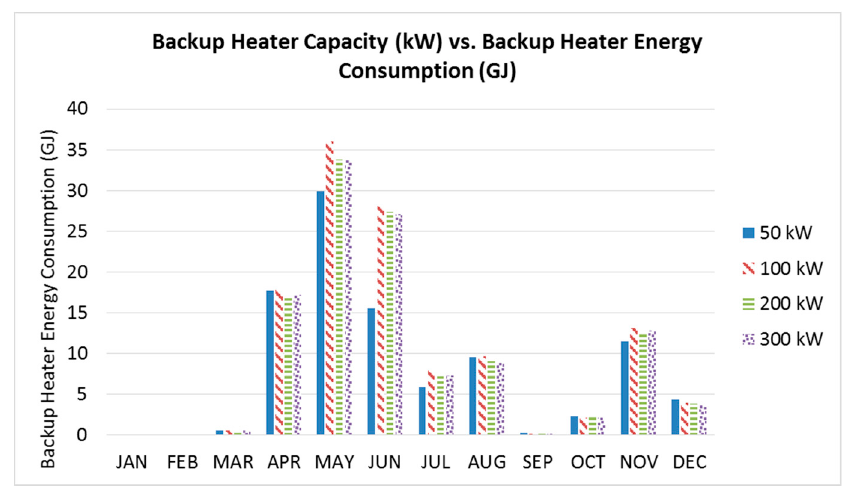
Figure 12. The impact of backup heater capacity on backup heater energy consumption.